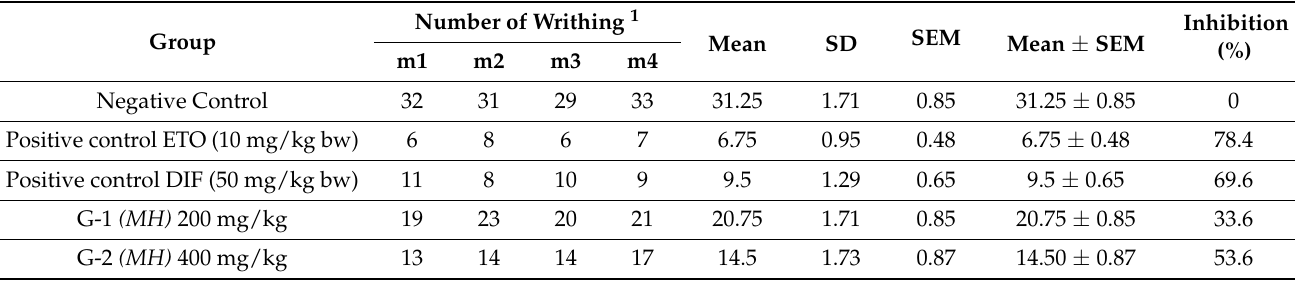
Table 1. The percentage of inhibition of writhing in acetic acid induced mice by analgesic activity of methanolic extract of Monochoria hastata .